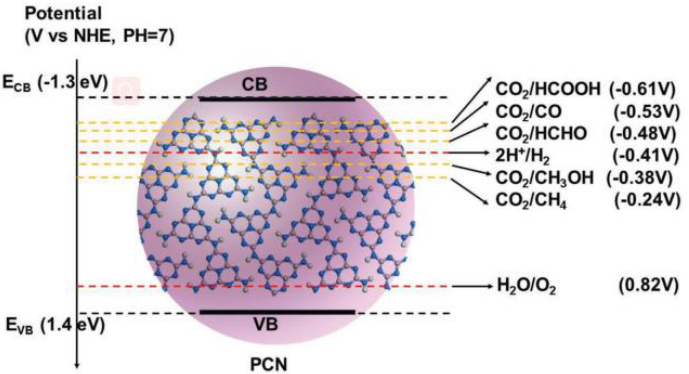
Figure 13. Schematic illustration of energy levels of PCN for photocatalytic CO 2 reduction. Reprinted with permission from Ref. [177]. Copyright 2019 John Wiley and Sons.